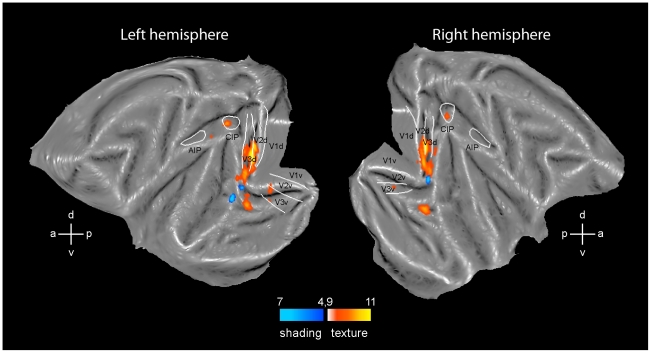
3D SfT and 3D SfS sensitive regions.Flatmaps of the left and right hemisphere of monkey template (M12) brain (Caret software) showing regions significant (fixed effects, p<0.05 corrected) in the conjunction of contrasts of the 3D SfT experiment (yellow to orange voxels, number of monkeys (n) = 2) and 3D SfS (blue voxels, n = 3) experiment. White lines indicate borders of V1-3 from Fize et al. [12] and of CIP and AIP from Durand et al. [22]. Color scales indicate t scores.